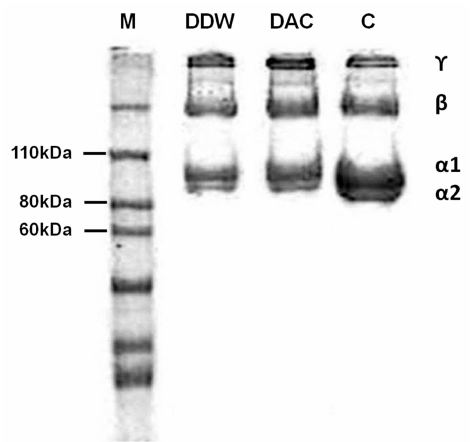
Figure 1. Protein patterns of collagens. SDS-PAGE bands were visualized using Coomassie brilliant blue staining. M,